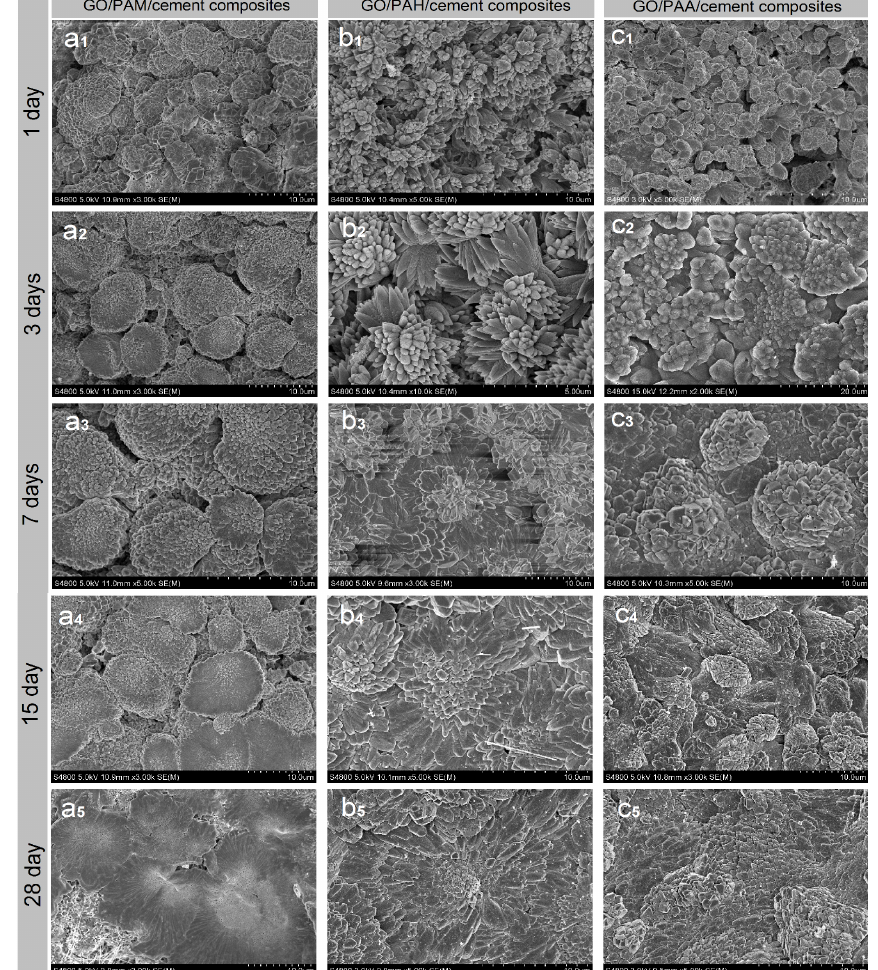
Figure 11. SEM images of GO/cement composites at different ages. ( a 1 – a 5 ): GO/PAM/cement composites; ( b 1 – b 5 ): GO/PAH/cement composites; ( c 1 – c 5 ): GO/PAA/cement